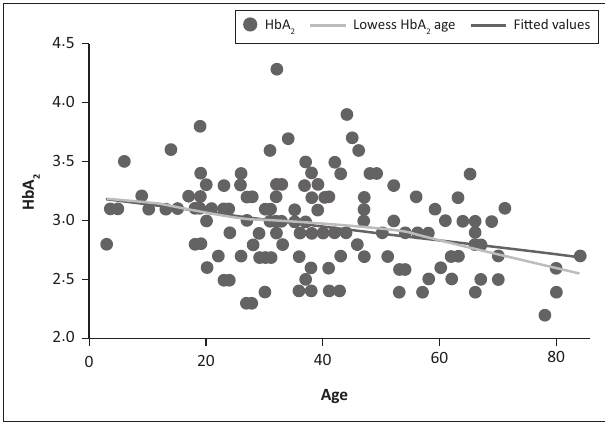
FIGURE 4: Scatterplot of haemoglobin A Africa, 01 October 2012 – 31 December